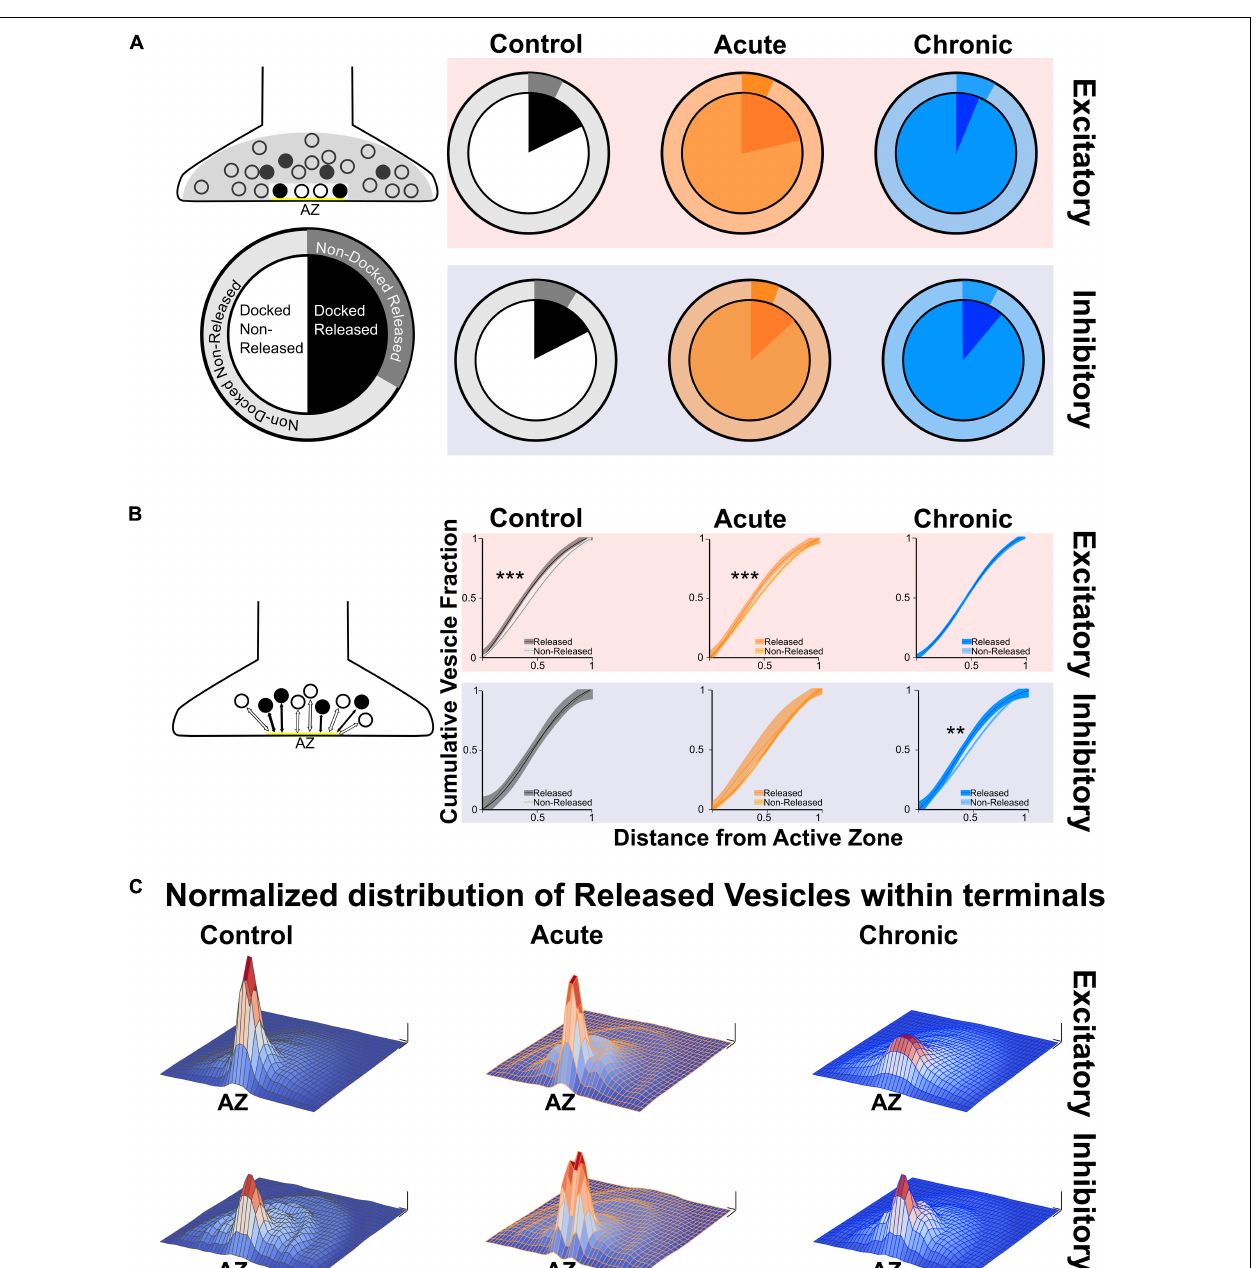
FIGURE 2 | Changes in released vesicles’ docking and spatial organization in chronic phase of epilepsy. (A) Ratio of released vesicles in the docked and undocked population. Left: Diagram and legend for each pie chart. Top: Excitatory synapses’ ratio of released vesicles (darker) in docked (inner pie chart) and undocked population (outer pie chart) in Control (gray), Acute (orange), and Chronic (blue) groups. Only the Chronic group shows a significant difference from expected frequencies based on control observation (Chi-squared test: p < 0.001). Bottom: Inhibitory synapses’ ratio of released vesicles (darker) in docked (inner pie chart) and undocked population (outer pie chart) in control (gray), acute (orange), and chronic (blue) groups. (B) Distance of released or non-released vesicles to the closest point on the active zone. Left: Diagram representing of how distance measures were taken at each synapse. Top: Sigmoid fit and 95% confidence interval of cumulative fraction of distance between released and not-released synaptic vesicles to the active zone at excitatory synapses in Control (gray), Acute (orange), and Chronic (blue) epileptic mice. Bottom: Sigmoid fit and 95% confidence interval of cumulative fraction of distance between released and not-released synaptic vesicles to the active zone at inhibitory synapses in Control (gray), Acute (orange), and Chronic (blue) epileptic mice. Paired t -test, Excitatory synapses: Control mice p = 0.0002 ( n = 40), Acute mice p = 0.0006 ( n = 41), Chronic mice p = 0.298 ( n = 112). Paired t -test, Inhibitory synapses: Control mice p = 0.06 ( n = 14), Acute mice p = 0.135 ( n = 13), Chronic mice p = 0.001 ( n = 28). (C) 2D histograms of released vesicles distribution at excitatory (top) and inhibitory (bottom) synapses across the three conditions with active zone at the origin of the XY plane. Control (gray), Acute (orange), and Chronic (blue). Each synapse was spatially normalized ( X - and Y -axis) and frequency is plotted on the Z -axis. Scale bars: 0.1 normalized size X and Y; 0.1 fraction Z -axis.